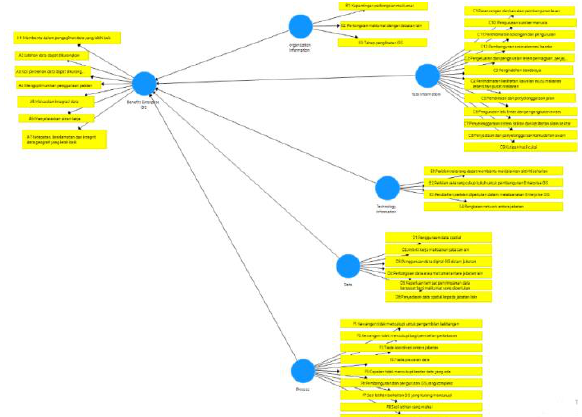
Figure 2. Structural Model between benefits of Enterprise GIS and the requirement for Enterprise GIS